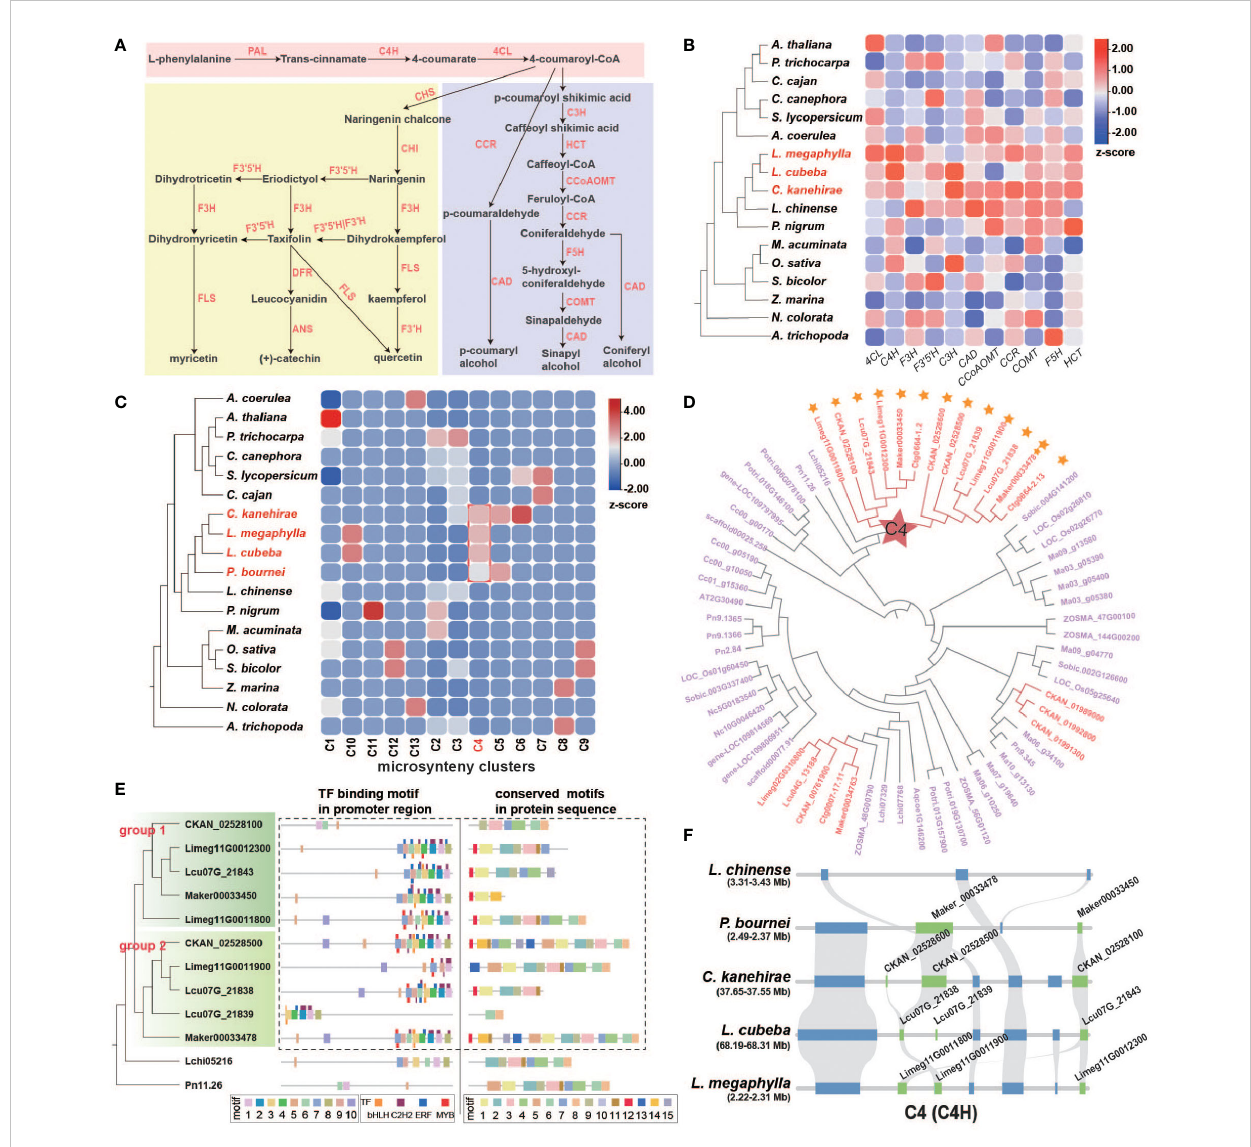
FIGURE 6 Characteristics of fl avonoid and lignin genes in Lauraceae. (A) Biosynthesis pathways of general phenylpropanoids, fl avonoids, and lignin. PAL, phenylalanine ammonia-lyase; C4H, cinnamate-4-hydroxylase; 4CL, 4-coumarate CoA ligase 4; CHS, chalcone synthase; CHI, chalcone isomerase; F3H, fl avanone 3-hydroxylase; FLS, fl avonol synthase; F3 ′ H, fl avonoid 3 ′ -hydroxylase; F3 ′ 5 ′ H, fl avonoid 3 ′ ,5 ′ -hydroxylase; DFR, dihydro fl avonol 4-reductase; ANS, anthocyanidin synthase; C3 ′ H, p-coumaroyl shikimate 3 ′ -hydroxylase; CCR, cinnamoyl-CoA reductase; CAD, (hydroxy)cinnamyl alcohol dehydrogenase; HCT, hydroxycinnamoyl-CoA:shikimate/quinate hydroxycinnamoyltransferase; CCoAOMT, caffeoyl- CoAO methyltransferase; F5H, coniferaldehyde/ferulate 5-hydroxylase; COMT, caffeicacid/5-hydroxyferulic acid O-methyltransferase. (B) Proportion of tandem and proximal duplication genes in 4CL , C4H , F3H , F3 ′ 5 ′ H , C3 ′ H , CAD , CCoAOMT , COMT , F5H and HCT gene families in each species. (C) Heatmap of 13 microsyntenic clusters of C4H gene families in 18 species. The Lauraceae-speci fi c cluster is highlighted by a red square. Colors in the heatmap indicate gene number in each cluster for each species. (D) Phylogenetic analysis of C4H gene families. The gene names of Lauraceae species are shown in red, and red stars represent Lauraceae-speci fi c gene clusters identi fi ed in (C) . Yellow stars show the tandem and proximal duplication (TD/PD) genes. (E) The phylogenetic tree of the C4H gene family (left), the distribution of motifs in the promoter sequences and the predicted transcription factor binding sites (TFBS) (middle), and the distribution of motifs in protein sequences (right) are shown. Thick squares represent motifs and thin ones represent TFBSs. Dashed boxes highlight genes and promoter motifs unique to Lauraceae species. (F) The syntenic block containing the C4H gene family within the Lauraceae-speci fi c microsynteny gene cluster (C4) identi fi ed in (C) . Here, this syntenic block was compared among L. chinense , P. bournei , C. kanehirae , L. cubeba , and L. megaphylla . Chartreuse squares represent C4H genes and blue squares represent other genes on the syntenic